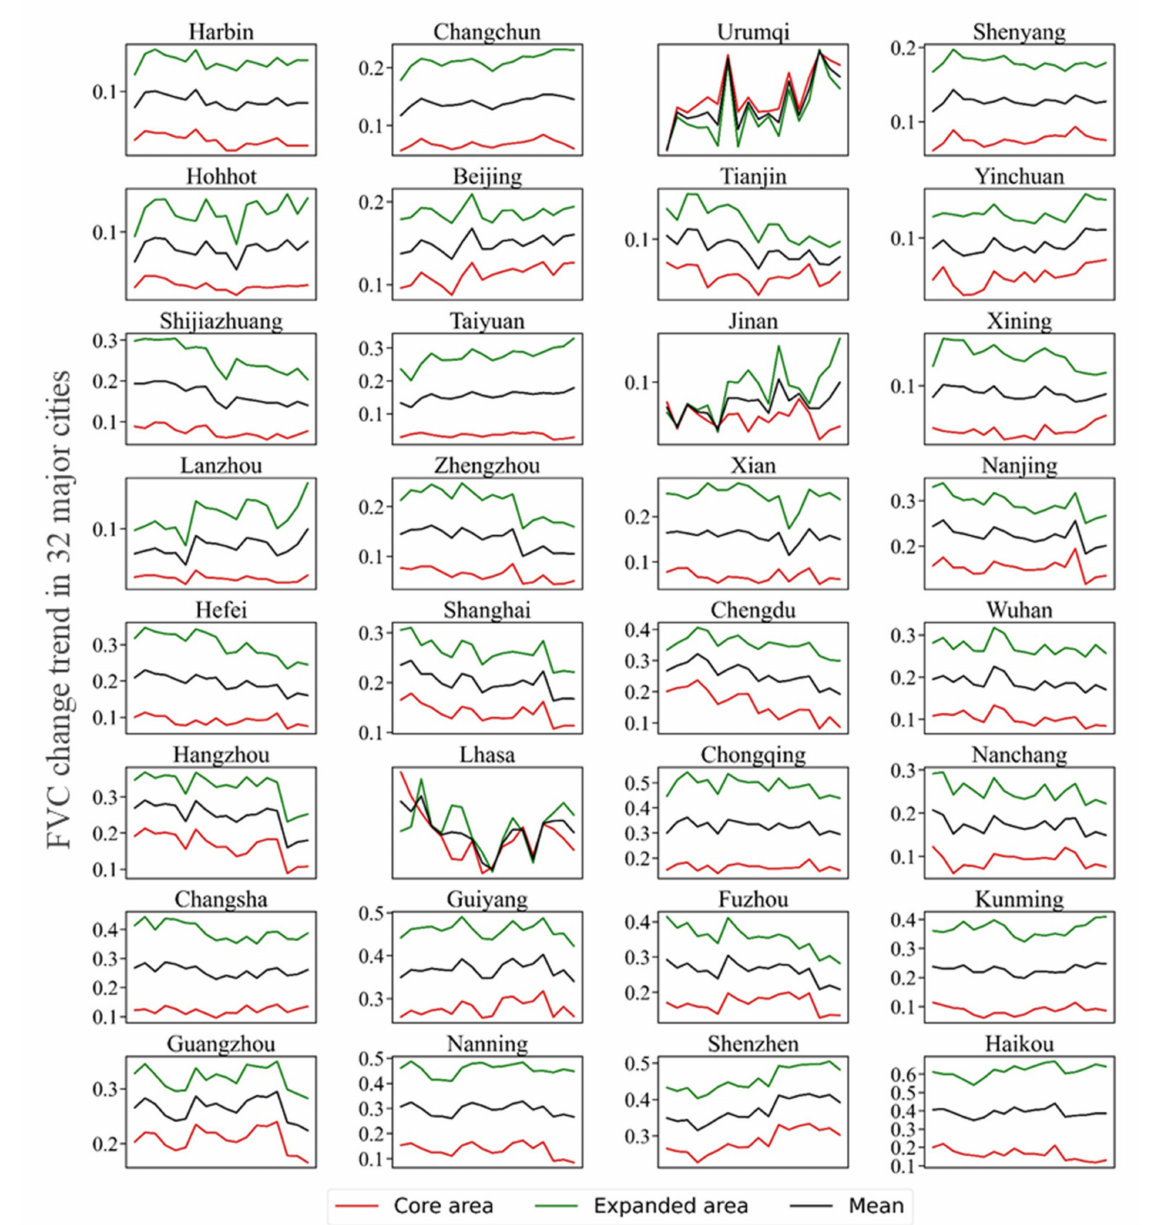
Figure 5. Temporal series changes in vegetation coverage in 32 Chinese cities from 2001 to 2018. Urban core areas and expansion areas had great differences in the urbanization process. The study found that the NTL of 32 major urban core areas in China remained unchanged, thus reflecting urban core area stability. Some cities’ urban expansion was rapid, such as Urumqi, Changchun, Yinchuan, Hefei, Chengdu, Wuhan, Nanchang, Changsha, Guiyang, and others. There was a significant trend of increasing NTL in the expansion area, thus reflecting the rapid urban expansion pattern of these cities. At the same time, there were some cities with small differences between the core areas and expansion areas, such as Beijing, Taiyuan, Lanzhou, Chongqing, Shenzhen, etc. Since urbanization, the area of each city has changed greatly. The expanded area of Shenzhen increased by 50.7%, and that of the Hefei expanded area increased by 614.2% (Figure